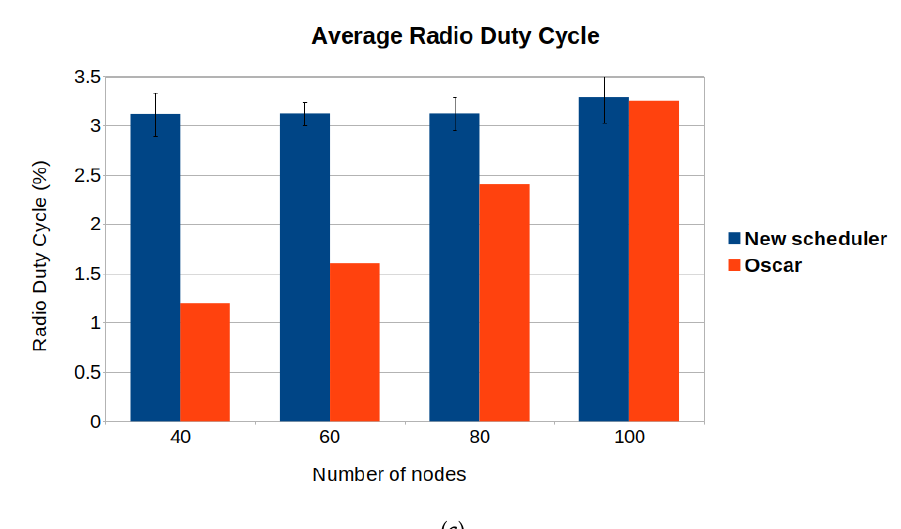
Figure 16. Comparison between OSCAR and the new scheduler considering different topology